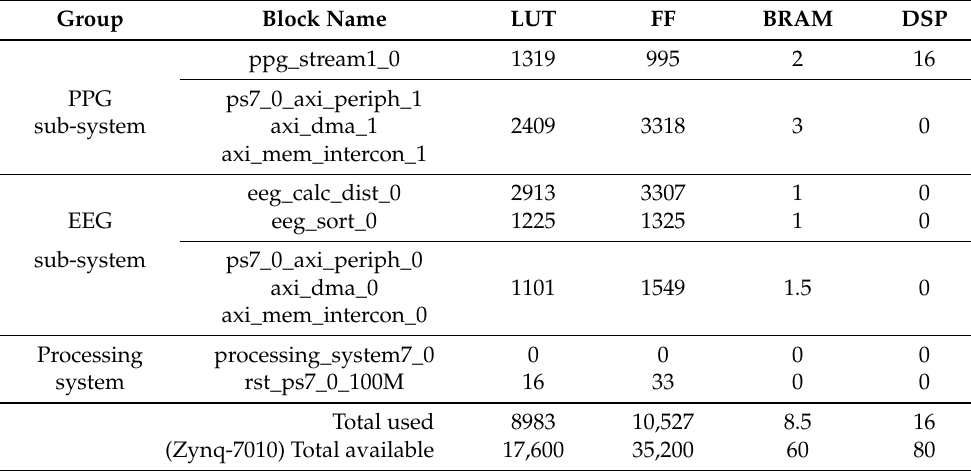
Table 2. Hardware resources used by the complete monitoring